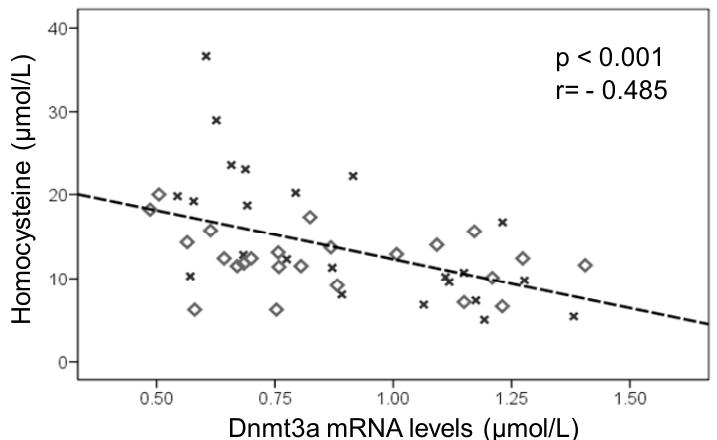
Figure 6. Correlation analysis between plasma homocysteine levels (µmol/L) and hepatic Dnmt3a mRNA levels (AU). Male rats are represented by squares and females by